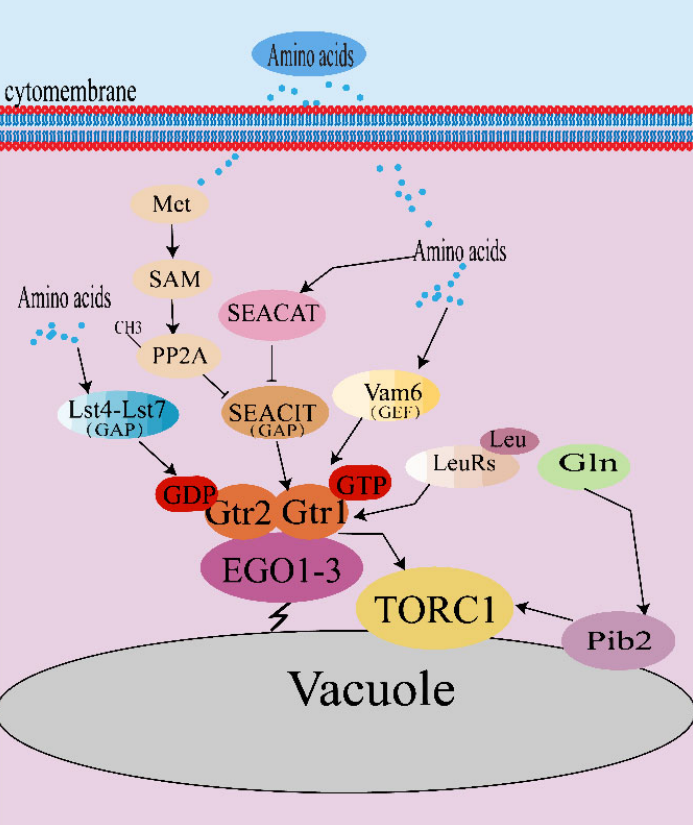
Figure 1. Amino acids regulate TORC1 activity in S. cerevisiae . TORC1 activation stimulated by amino acids mainly depends on the stimulation state of Gtrs, and the stimulation state of Gtrs is closely regulated by GEF and GAP proteins. LeuRS has also been reported to play a role in TORC1 activation. In addition, glutamine ‐ induced TORC1 activation need the mediation of Pib2.